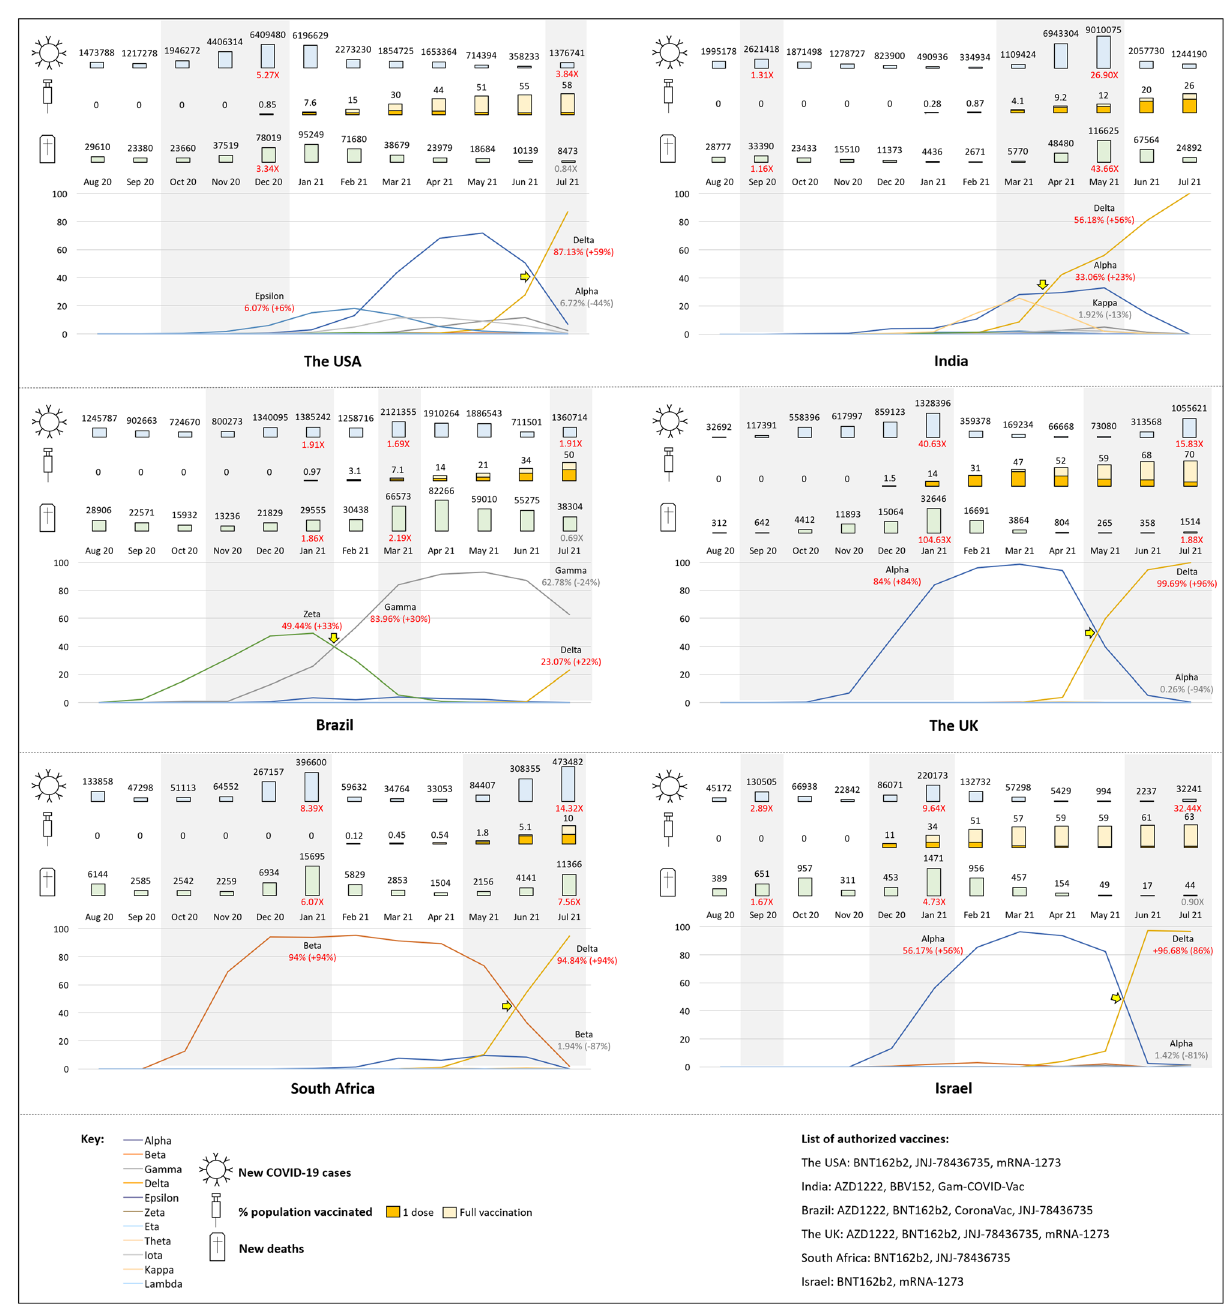
Figure 2. Monthly data on new COVID-19 cases and deaths, vaccination status and proportions of SARS- CoV-2 variants. Grey areas cover the ascending phases of new COVID-19 cases. Yellow arrows indicate the time points of major lineage interchange. The fold and percentage changes were relative to the baseline (the value right before the start of an ascending phase). Please note that owing to highly variable lag time between collection and submission dates, the latest proportions of SARS-CoV-2 variants in recent months (for instance, June and July 2021) might not be thoroughly